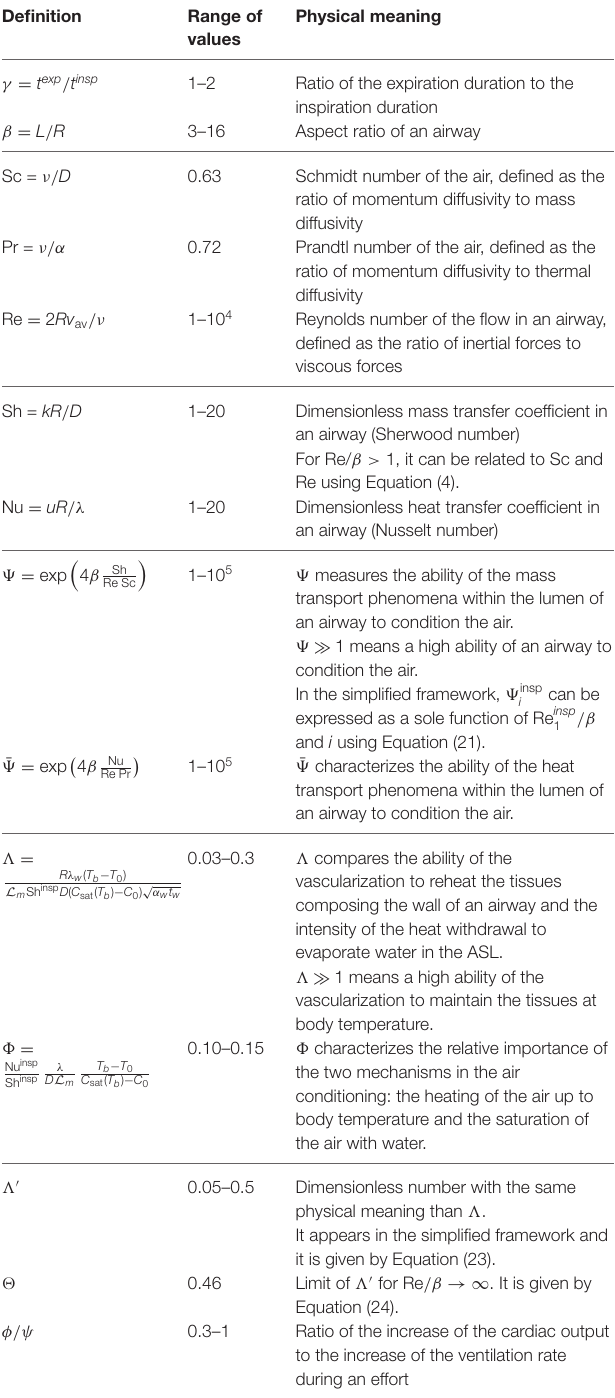
TABLE 1 | Summary of the dimensionless numbers appearing in the